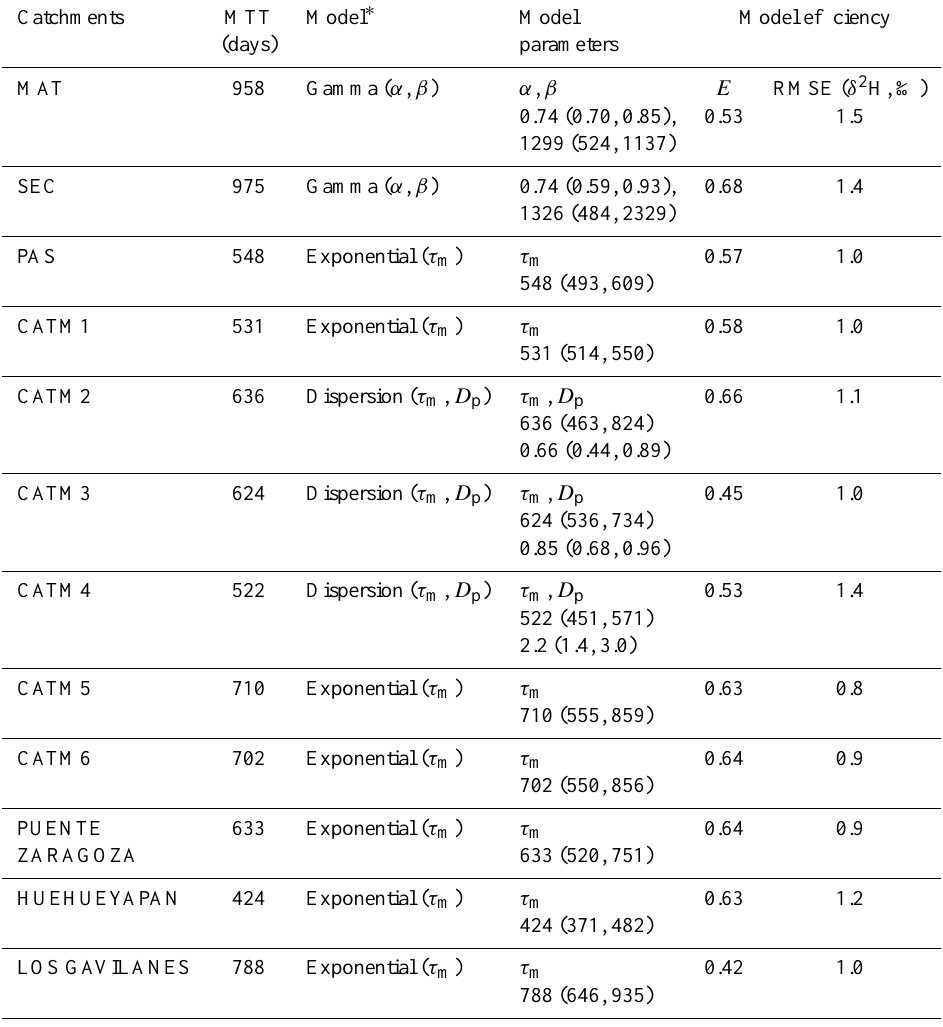
Table 4. Stream baseflow MTTs, and corresponding model parameters and model